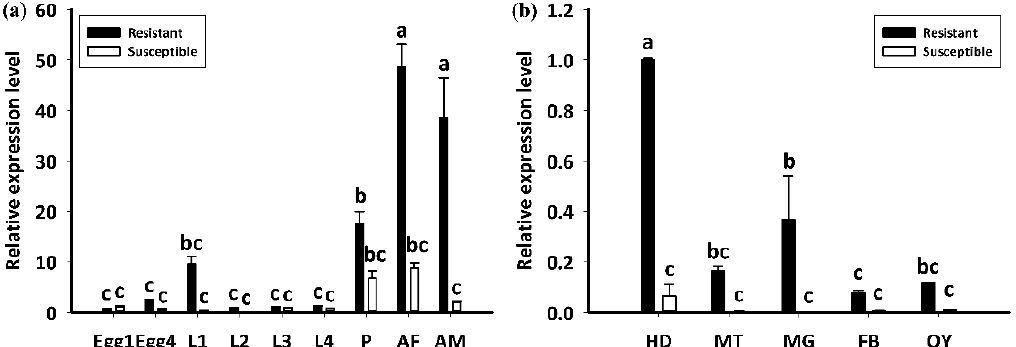
Figure 8. Developmental and spatial expression patterns of LdGSTu1 . ( a ) Transcriptional expression levels of LdGSTu1 during different developmental stages. Samples included: Eggs; first, second, third, and fourth instar larvae (L1–L4); pupae (P); female adults (AF); and male adults (AM). ( b ) Transcriptional expression levels of LdGSTu1 in the tissues of adults. HD, heads; MT, Malpighian tubule; MG, midgut; FB, fat body; OY, ovary. Each value is the mean ± SE of three collections. Differences among multiple treatments were analyzed using one-way ANOVA, followed by a Tukey’s HSD multiple comparison test. There was no significant difference among treatments with the same alphabetic letters (e.g., a, b, and c).